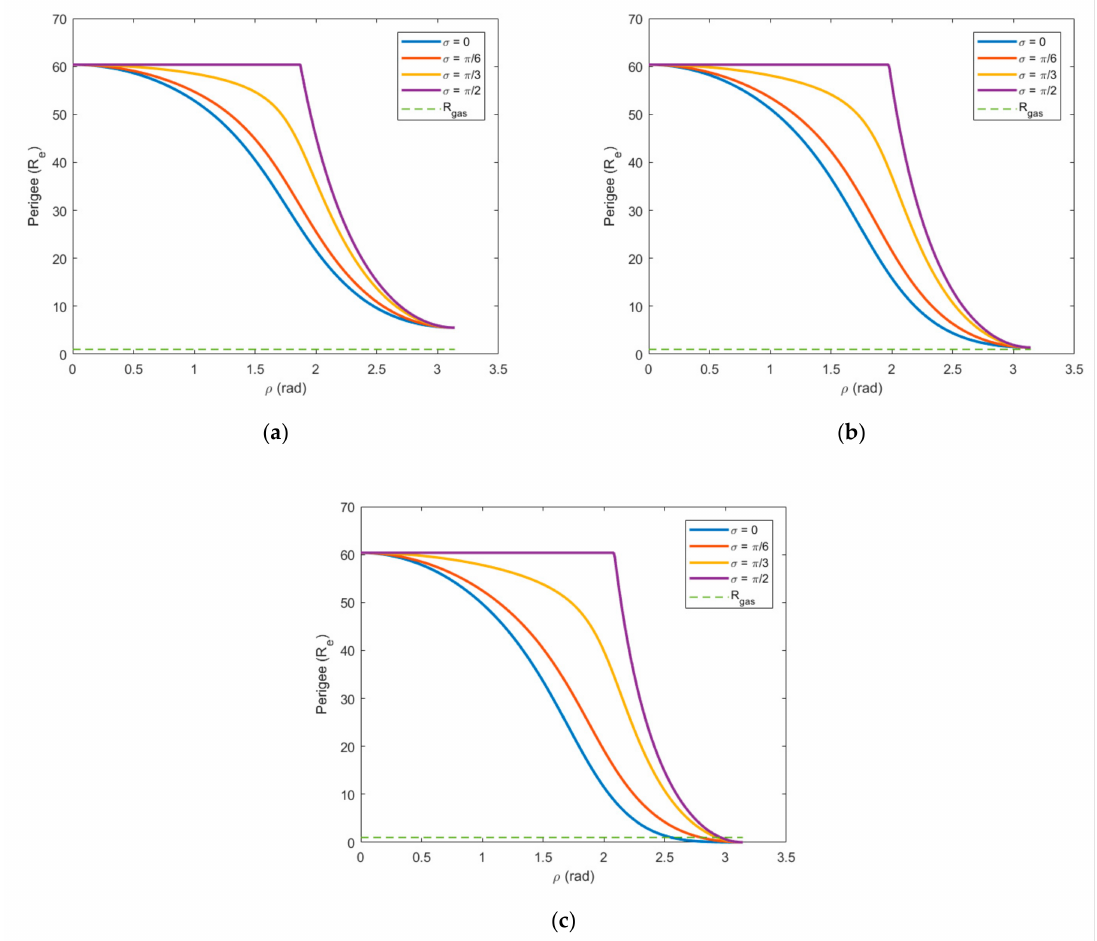
Figure 7. The variation in the perigee radius with ρ when v ∞ < v moon . ( a ) v ∞ = 0.6 km/s; ( b ) v ∞ = 0.8 km/s; ( c ) v ∞ = 1